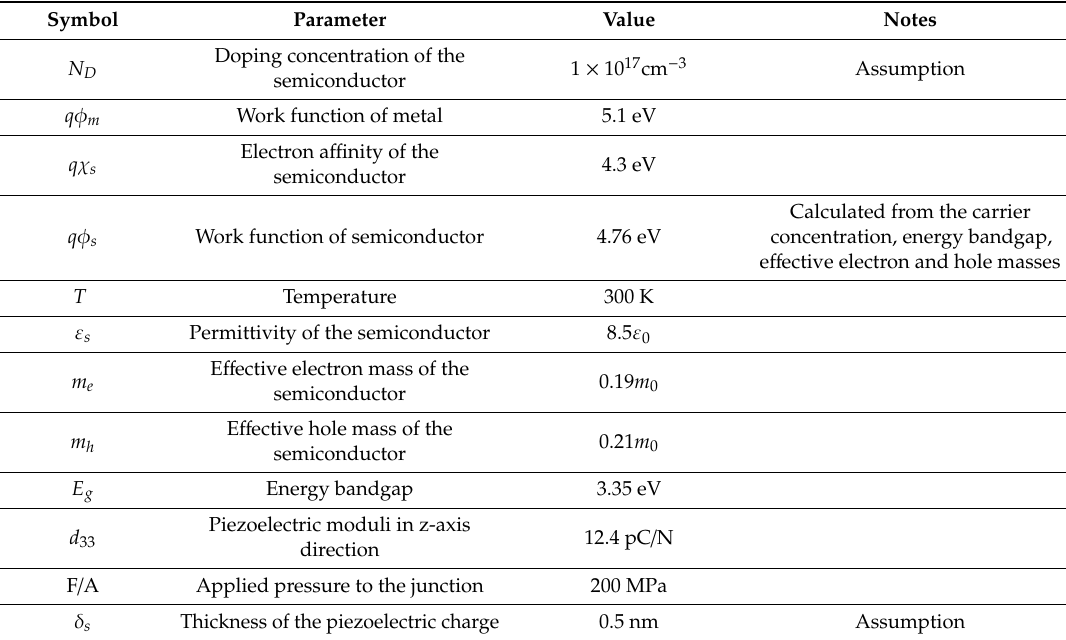
Table A5. List of parameters used in plots of Figure